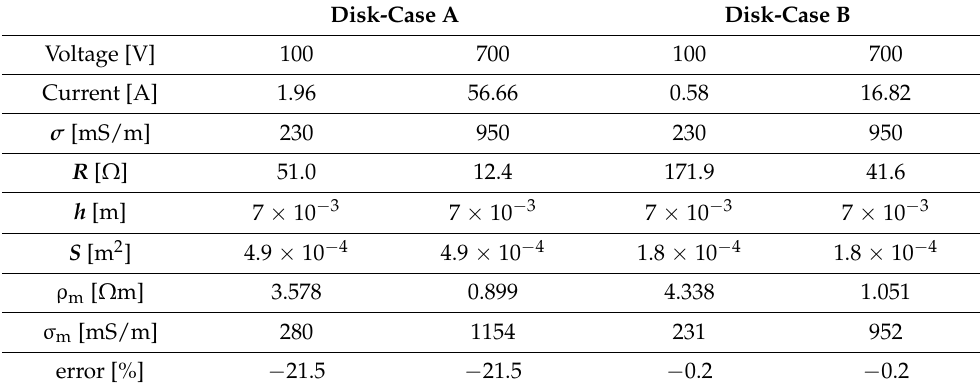
Table 4. Conductivity estimation using the FEA, using the hypothesis of fixed conductivity medium and assessment of the error of estimation for disk-shape model with variable measurement electrode.